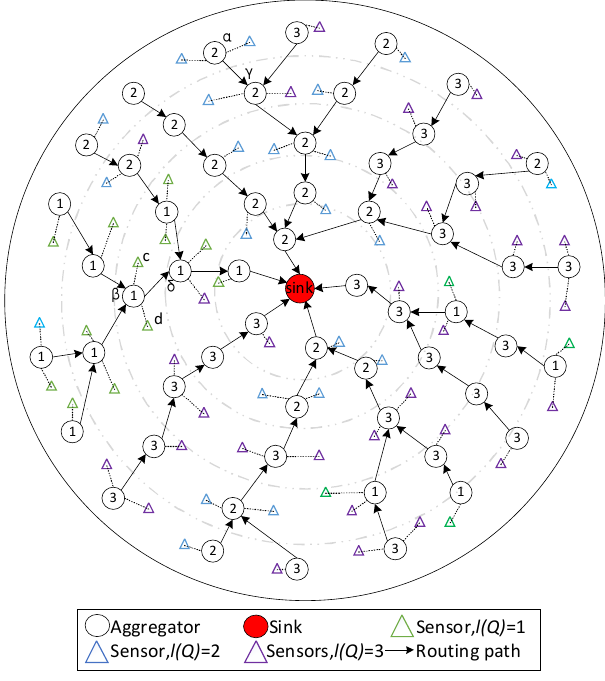
Figure 8 . The sample operations in phase 4. Figure 8. The sample operations in phase